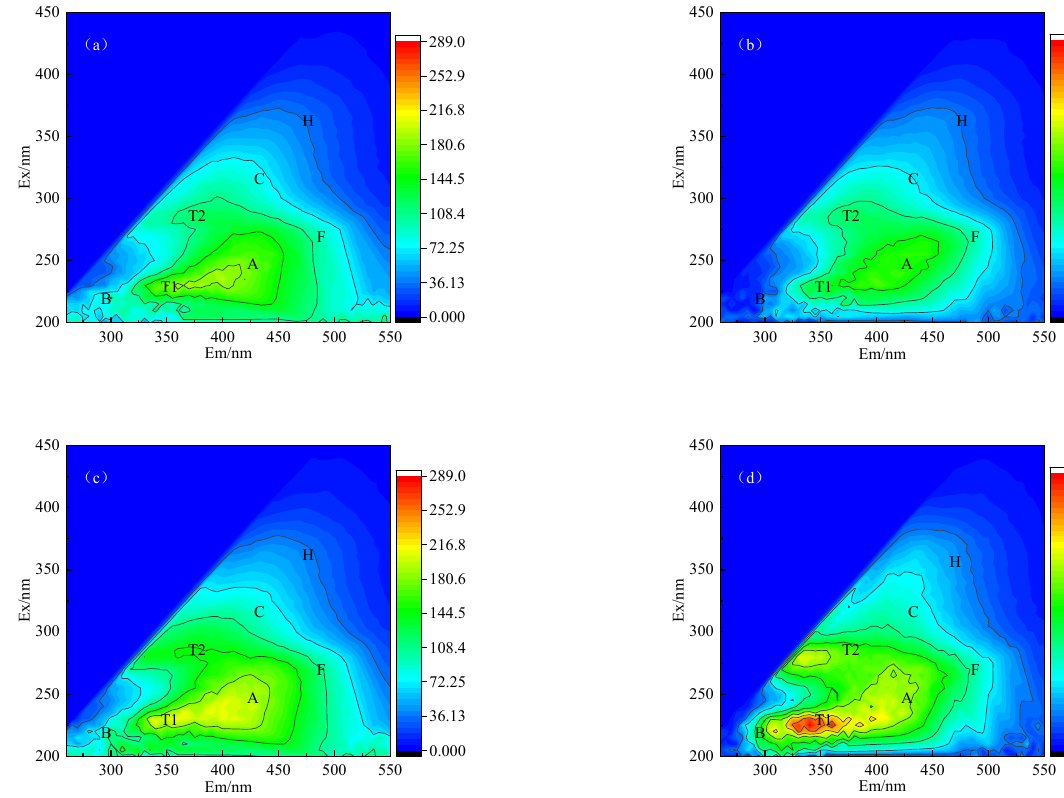
Figure 2. Three-dimensional excitation–emission matrix spectroscopy of the dissolved organic matter from the sampling point #4 of Shahu Lake in April ( a ), May ( b ), June ( c ), and July ( d ). Fluorescence abundance showed an increasing trend at each sampling point between April and July. From spring to summer (April–July), the fluorescence abundance of tryptophan-like and tyrosine-like substances gradually increased, meaning that the amounts of protein-like substances increased. Zhang et al. [3] studied the changes of DOM molecular composition in June and November, which was during and after the algal bloom in Taihu Lake, finding that during the peak of the Cyanobacterial bloom in June, DOM was already combined with algal metabolites and showed the characteristics of biological mixture. They suggested that the temporal variation in the molecular characteristics of DOM in the Taihu Lake basin from summer to winter might be related to microbial metabolism [3]. Jia et al. [7] studied the relationship between DOM and phytoplankton response in Baiyang Lake in autumn (September–November) and found that the tryptophan-like contribution showed a clear downward trend from early to late autumn as phytoplankton abundance decreased. Therefore, it can be speculated that changes in DOM composition in overlying water of Shahu Lake might be related to phytoplankton and microbial activities. Five major fractions were identified using PARAFAC for fraction extraction of DOM from Shahu Lake from April to July (Table 2, Figure 3). C1 (E x /E m = 260/460 nm) and C3 (E x /E m =245/400 nm) were jointly classified as humic-like substances. C1 corresponds to the UV-zone humic-acid-like fluorescence peak of the F-peak, which generally represents terrestrially derived organic matter [31]. C3 is a microbially transformed authigenic humic-like component with a similar spectral pattern to the A-peak [32], which indicates the UV zone fulvic acid-like fluorescence peak and is probably derived from algal and microbial residue degradation [33]. C2 (E x /E m = 230, 280/340 nm) and C4 (E x /E m =300/365 nm) are tryptophan-like substances that correspond to the peaks T1 and T2 of tryptophan-like fluorescence, and they are generally the metabolites of the microbial degradation [15,34,35]. This will be represented by (C2+C4) in the subsequent discussion. C5 (E x /E m =220/300 nm) was identified as a tyrosine-like substance, corresponding to a tyrosine-like